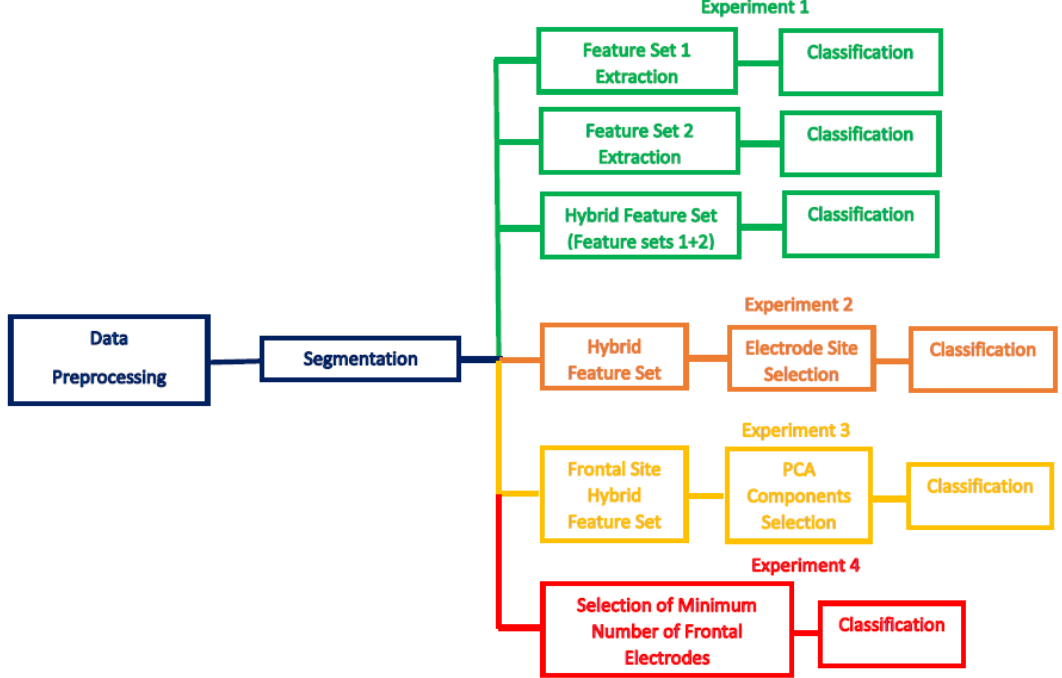
Figure 3. A workflow to explain the three experiments of the proposed MSD system .